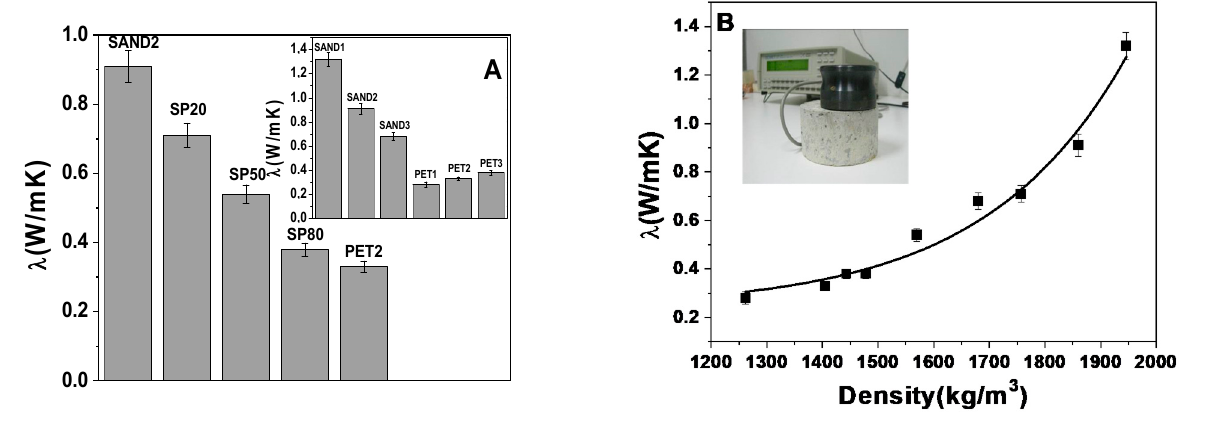
Figure 6. ( A ) Thermal conductivities of SAND2, SP and PET2 samples (with 500 g of aggregate). In the inset: thermal conductivities of bare SAND and PET specimens. ( B ) thermal conductivities vs. sample density.